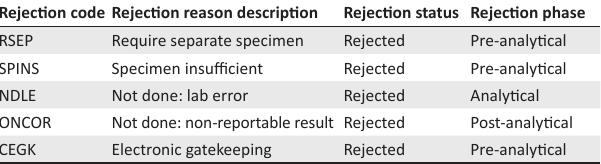
TABLE 1: Example of some rejection codes and rejection reasons used to assign the rejection status and rejection phase values in a lookup table for HIV serology